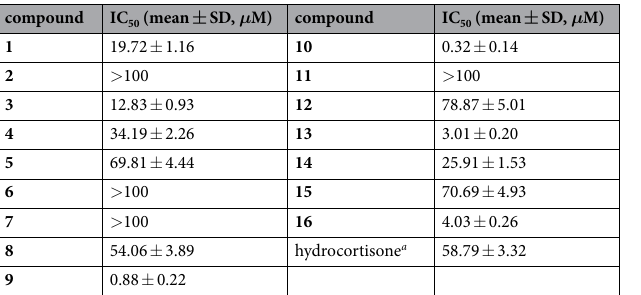
Table 4. Inhibitory effects of compounds 1 – 16 on NO production induced by LPS in macrophages. a Positive